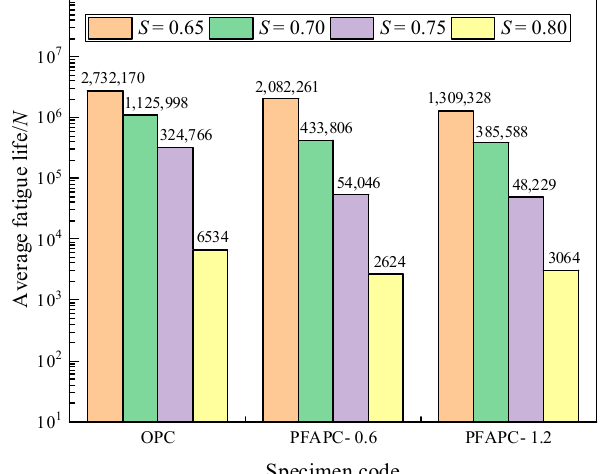
Figure 5. Average fatigue